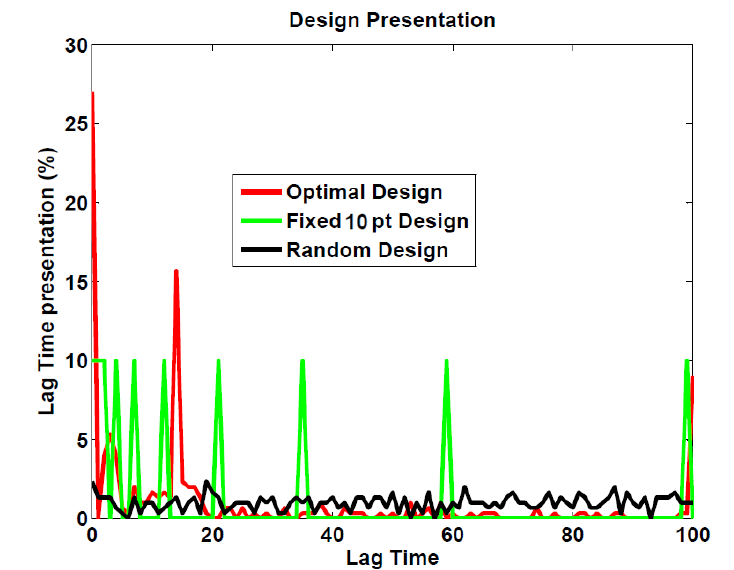
Figure 4. Lag time distribution for each experimental design (over the 30 simulations).